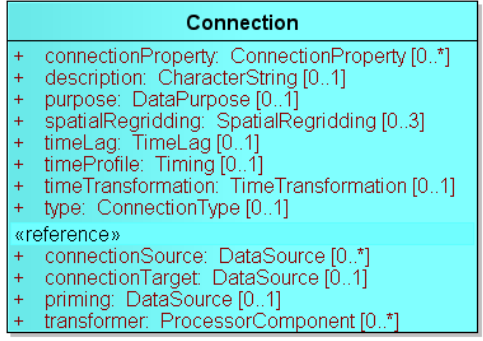
Fig. 2. The Connection class in ConCIM 1.5 which describes the properties of a configured connection between two